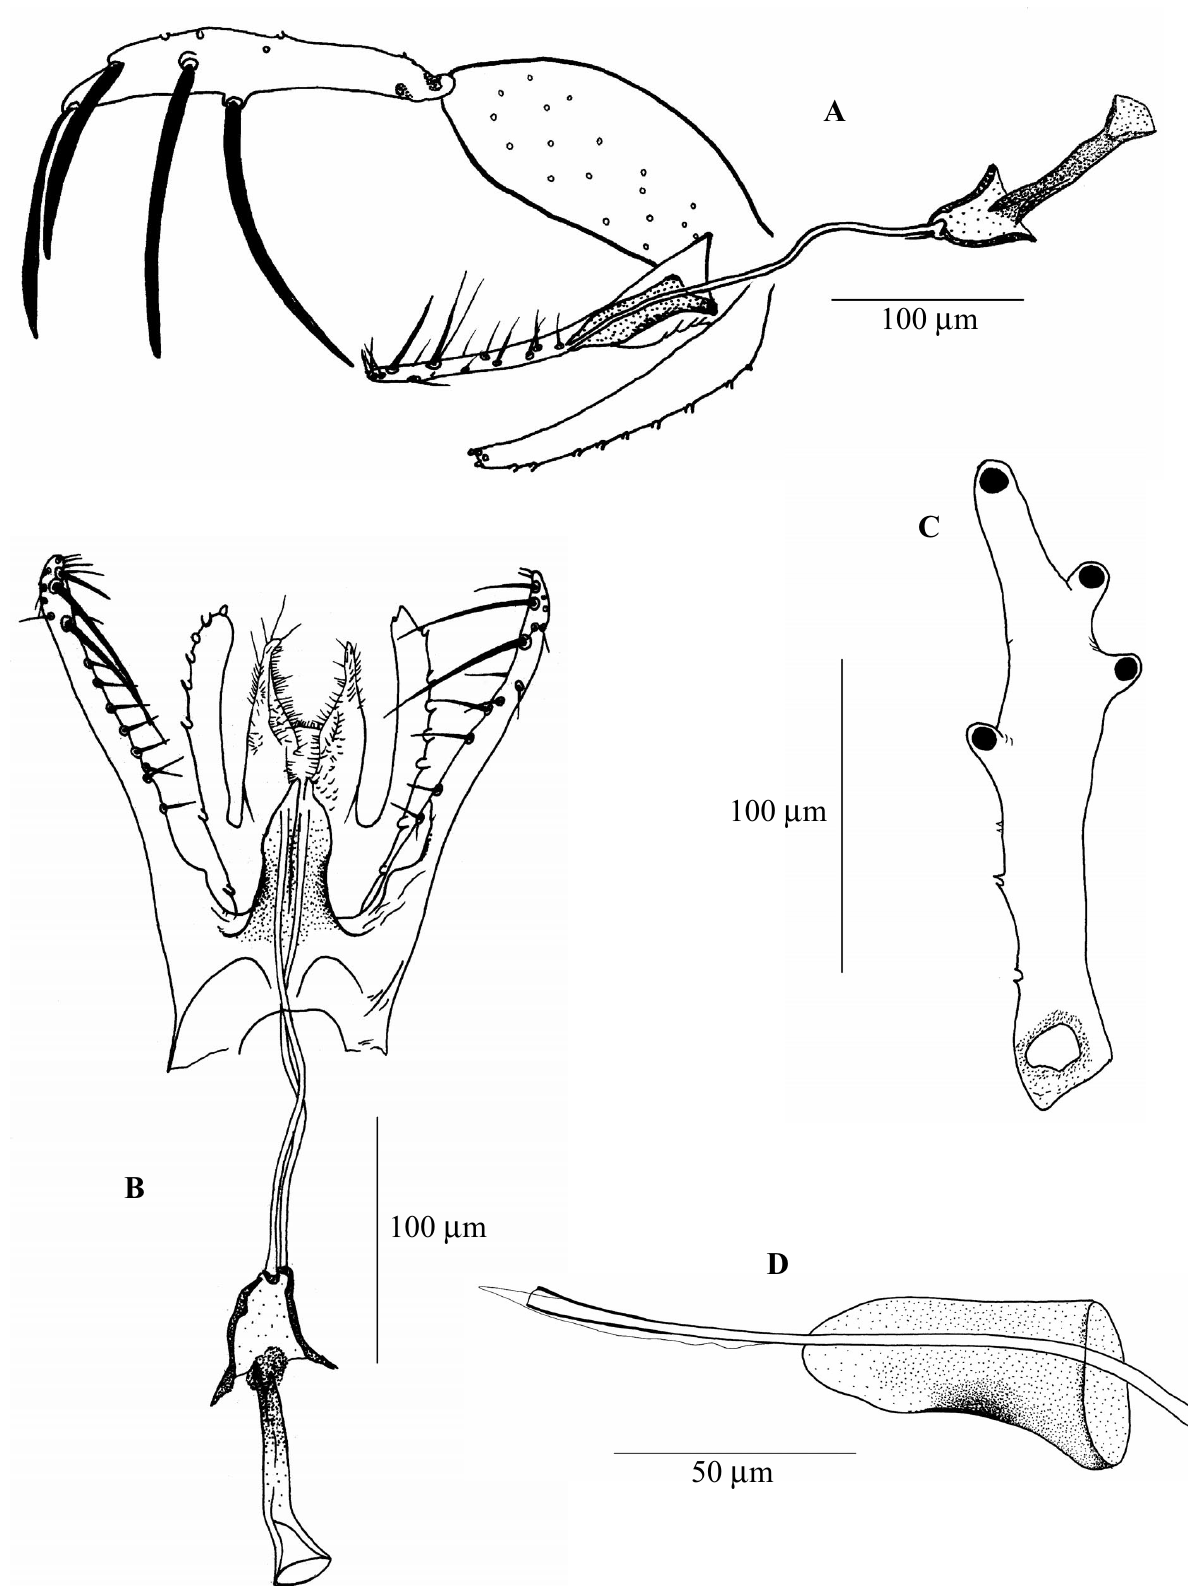
Fig. 3. – C. barbazani n. sp. mâle. A : génitalia (vue latérale); B : valves péniennes, paramères, surstyle et cerques (vue dorsale); C : style; D : valve pénienne (vue